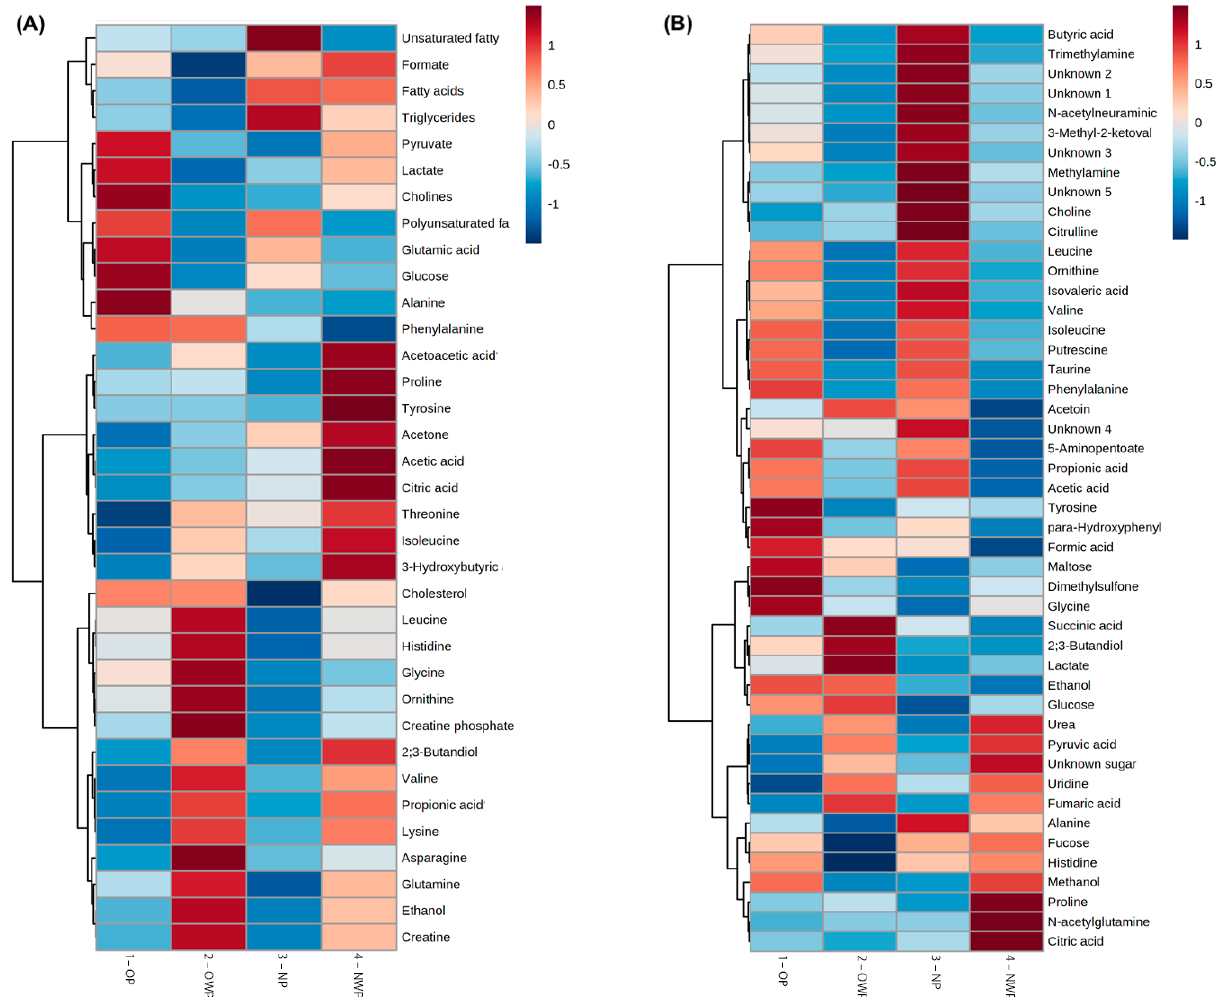
Figure 4. Heatmap with the groups average concentrations log-transformed of the identified plasma ( A ) and saliva ( B ) biofluids.